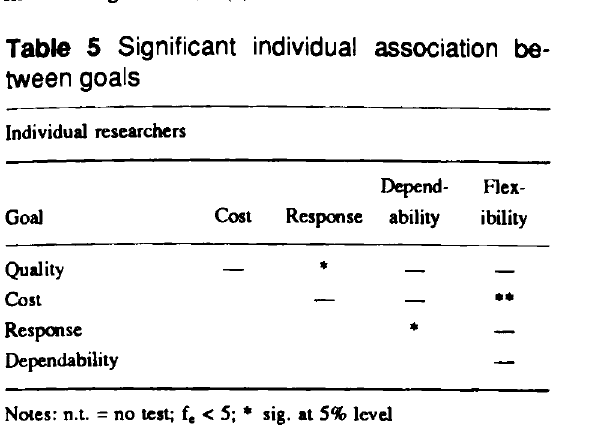
Table 5 Significant individual association be tween goals